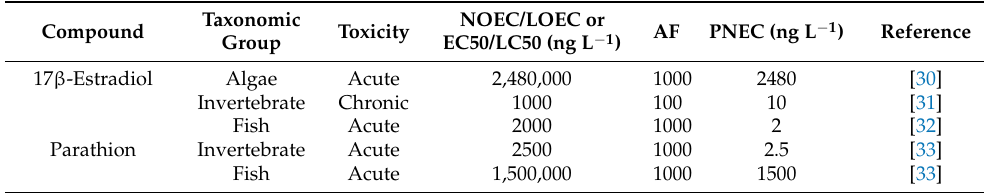
Table 2. Aquatic toxicity data and PNEC values of the target compounds.